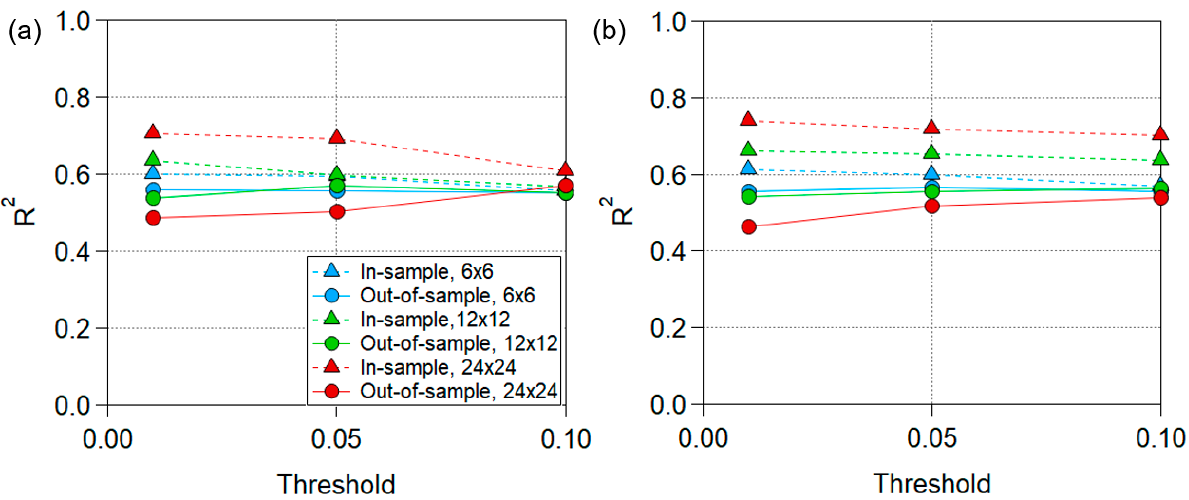
Figure 8. R-squared for administrative district model: ( a ) excluding month factor and ( b ) including month month factor.